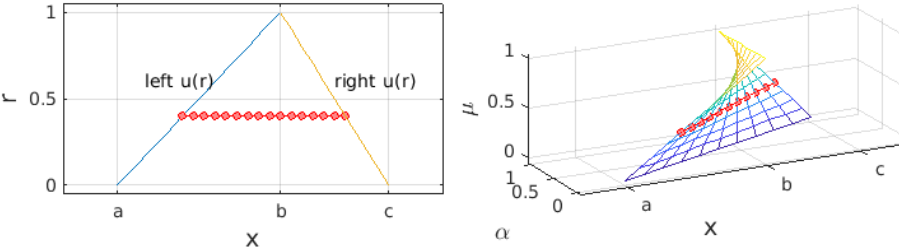
Figure 1. Triangle membership function of a fuzzy number X with the cut at membership level r = µ = 0.4: left graph—parametric fuzzy number (FN), right graph—horizontal